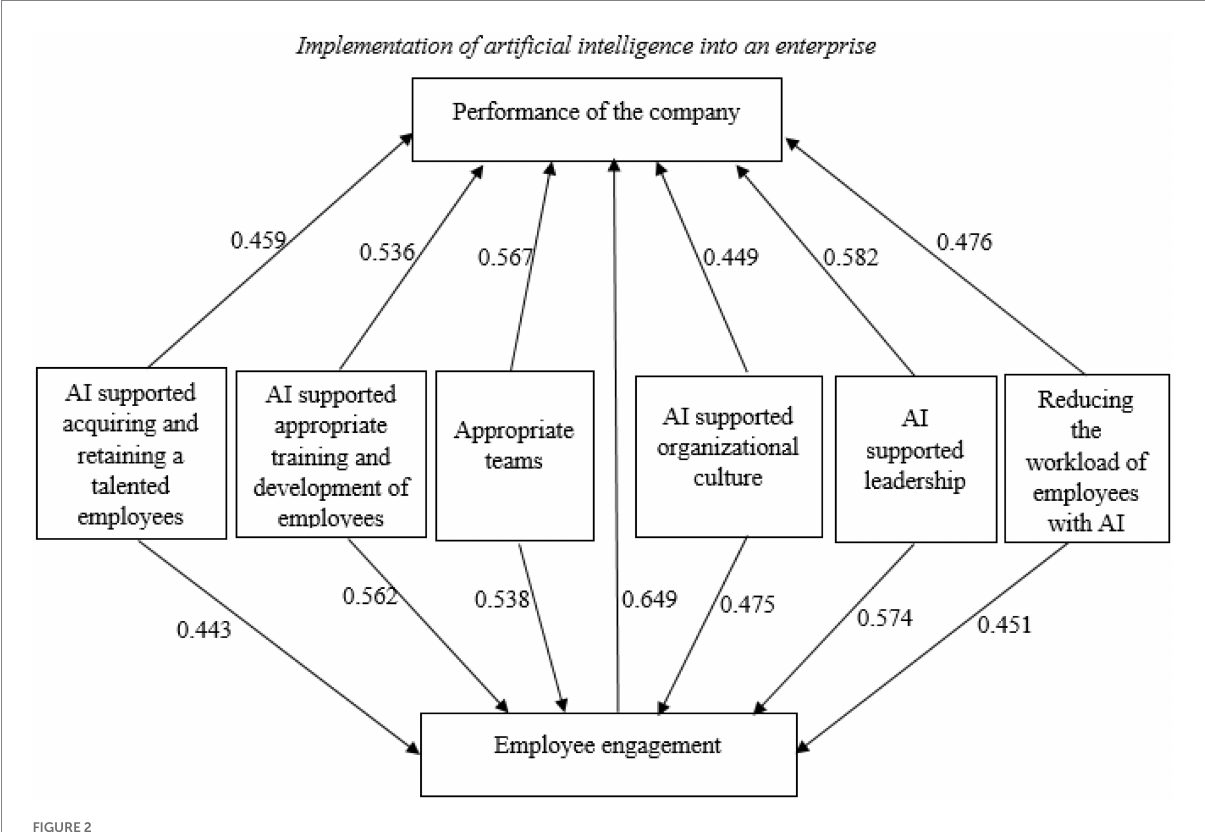
FIGURE 2 The conceptual model with the values of path